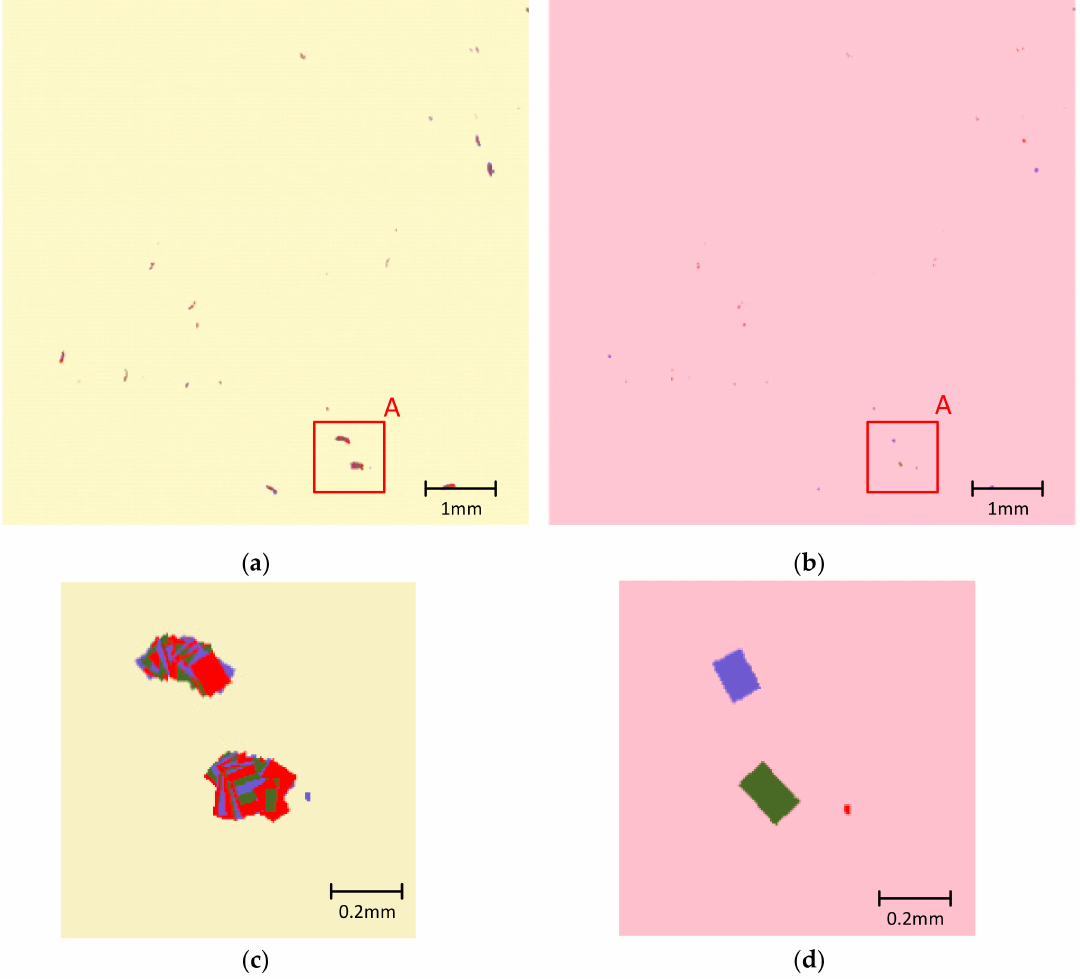
Figure 17. Comparison between stitching results of point targets before and after the scanning path correction work. ( a ) Original distribution map of point defects on the tested surface, with worm-like defect distribution in existence of system errors; ( b ) The corrected distribution map after scanning path correction process; ( c ) Detailed view of part A in the original distribution map; ( d ) Detailed view of part A in the corrected distribution